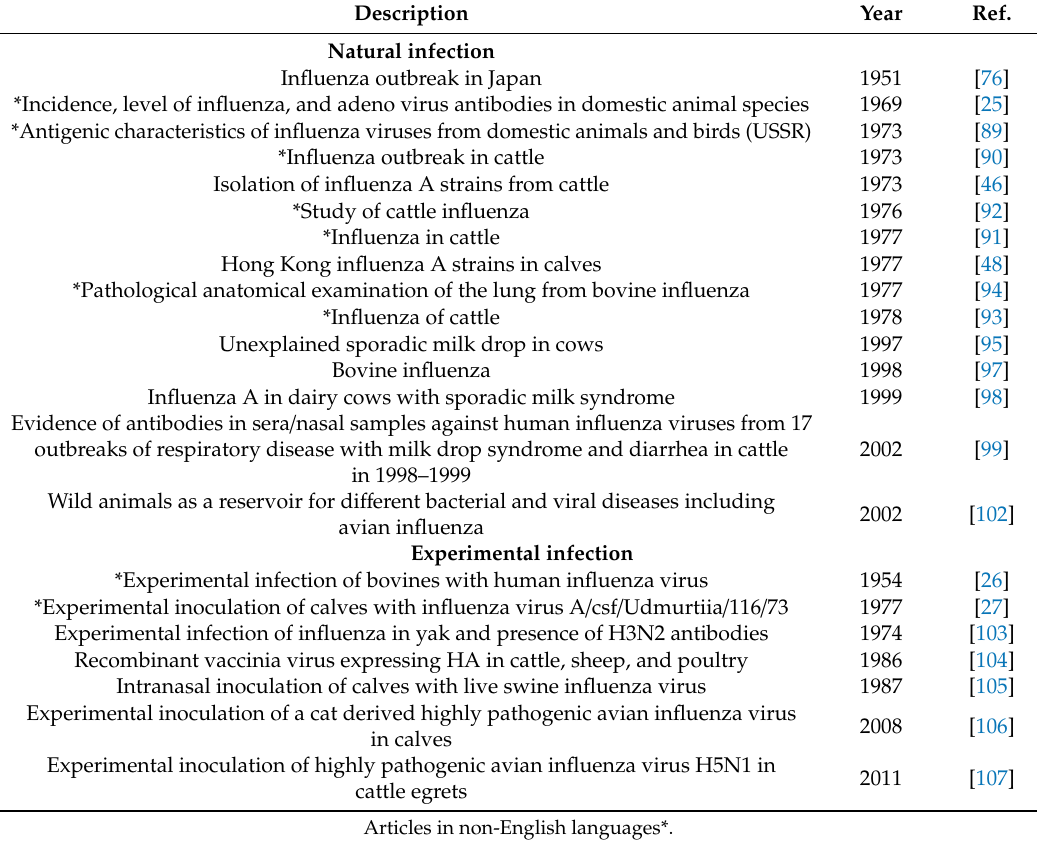
Table 1. Natural and experimental cases of influenza A associated with ruminant